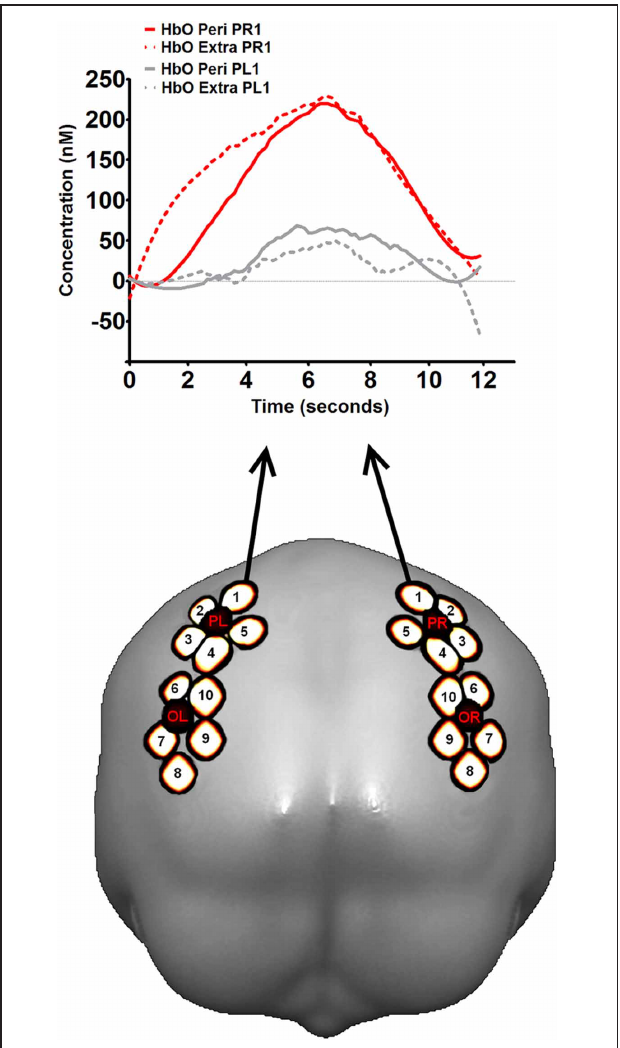
FIGURE 3 | The fNIRS recording. In the bottom part of the figure, the location of the regions investigated in the present study, with cerebral projections of detectors (black) and channels (white) superimposed on a template brain (occipital view). The letters of the detectors indicate the lobe (P: parietal; O: occipital) and the hemisphere (L: left; R: right). The number indicates the source. Channels are named according to the source-detector pair: for instance, detector OL and source 5 created the channel OL5. Further details can be found in Cutini et al. (2011a,b). In the top part of figure, hemodynamic response profile in symmetrical channels PR1 and PL1 (i.e., right vs. left parietal lobe) during virtual line bisection. A visual inspection of the response profiles in the two channels suggests a marked difference for what concerns the presence of task-related hemodynamic activity in the two parietal